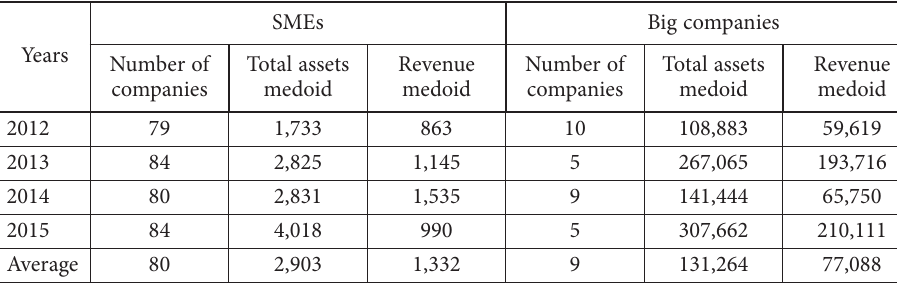
Table 2. The results of k-medoids cluster analysis (source: own calculation by R Studio) (million tugriks) SMEs Big companies Years Number of Total assets Revenue Number of Total assets Revenue companies medoid medoid companies medoid medoid 2012 79 1,733 863 10 108,883 59,619 2,831 1,535 65,750 2015 84 4,018 990 5 307,662 210,111 Average 80 2,903 1,332 9 131,264